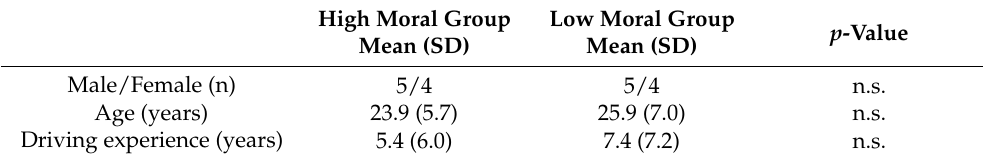
Table 2. Profile of the